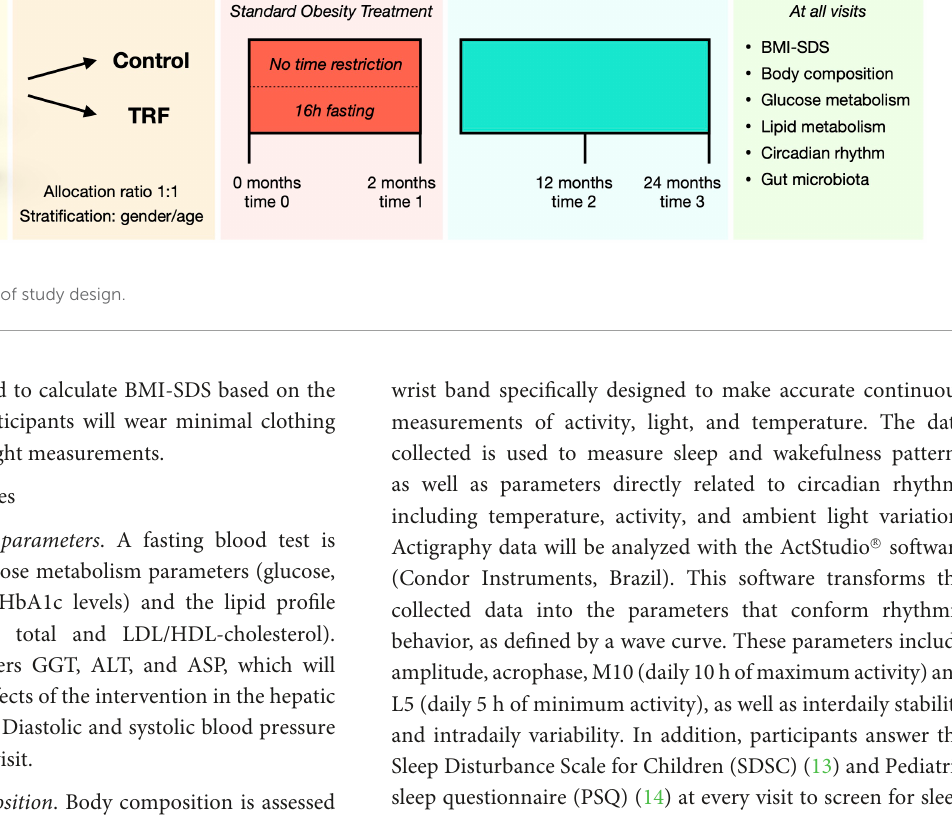
FIGURE2 Schematic representation of study design.